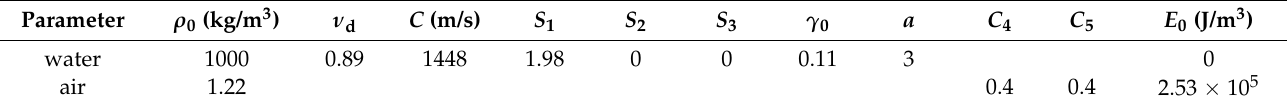
Table 4. Material parameters of fluid.